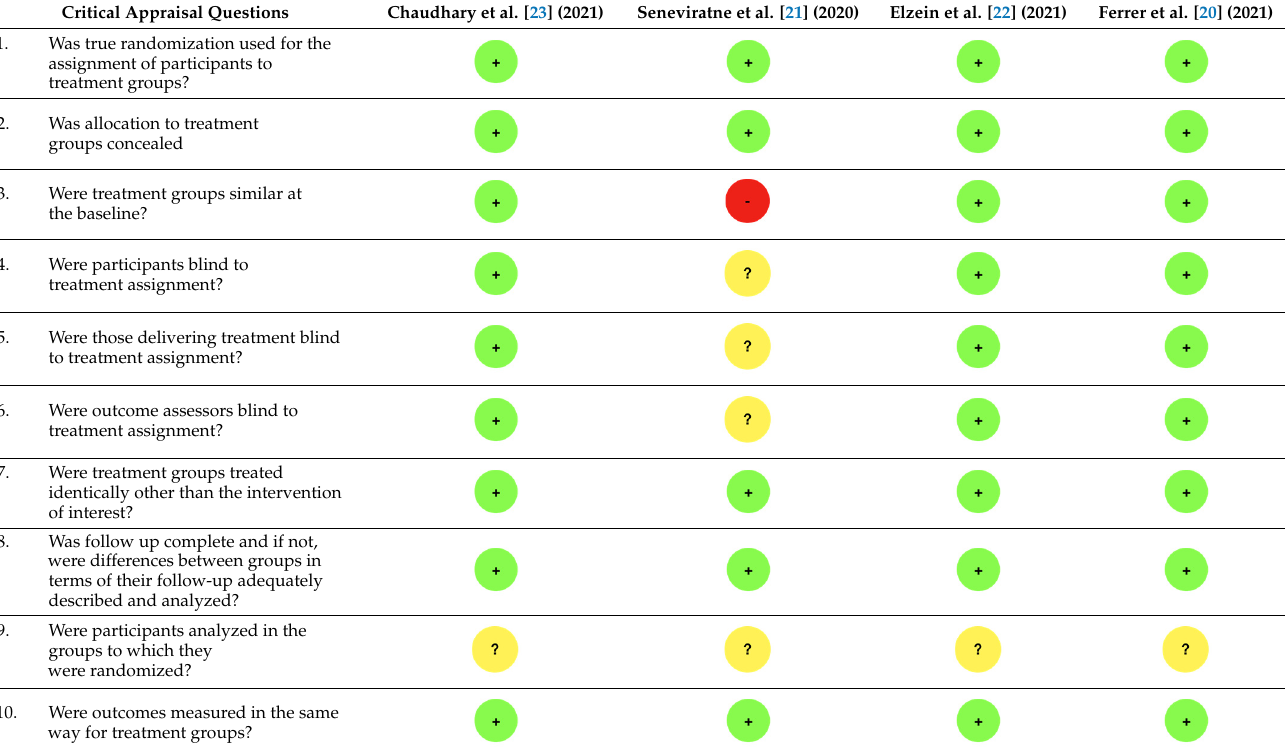
Table 2. JBI Critical Appraisal Tool [19] for RCTs. Reprinted with permission from JBI. Copyright 2020.